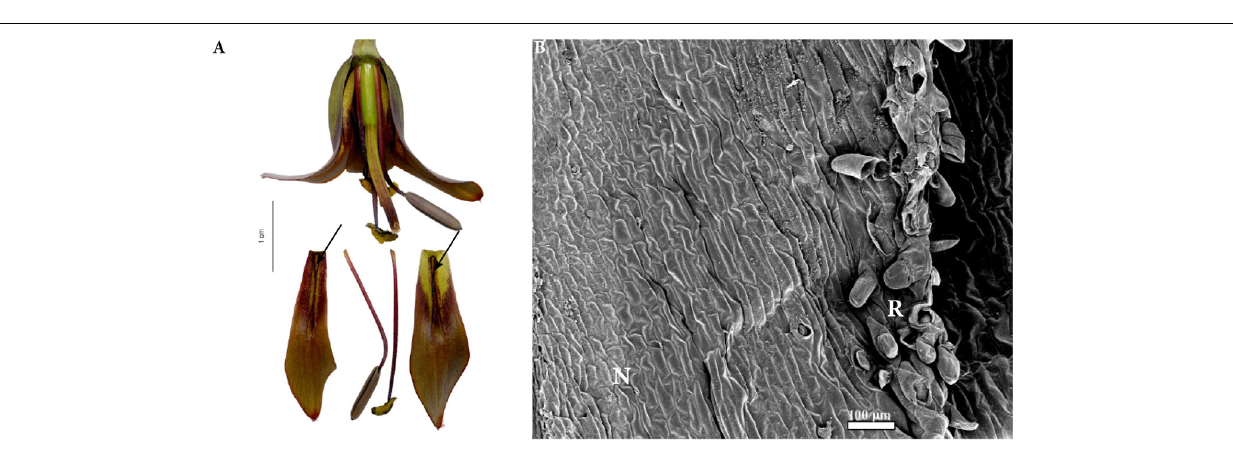
F. imperialis ( Figure 4A ) and F. eduardii contrasted sharply with the surrounding dark green background. Nectaries of F.